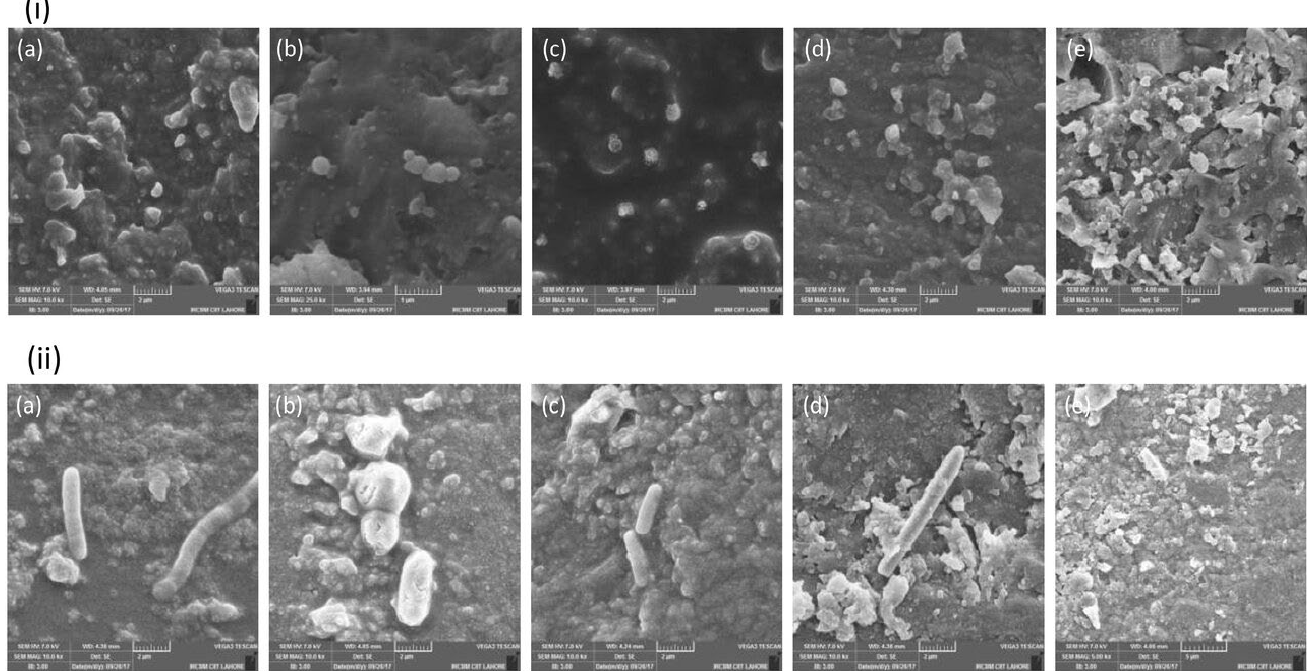
Figure 5. SEM images showing attachment of (i) Streptococcus mutans and Lactobacillus acidophilus ( ii ) on ( a ) E (control), ( b ) ET1, ( c ) ET2, ( d ) EZ1, and ( e ) EZ2 at 48 h. Representative images were taken at 7 kV, and magnification was 10k ×.